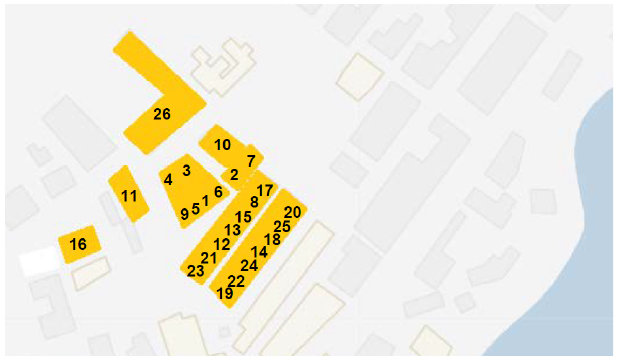
Figure 5. Case study: Location of the distribution network.